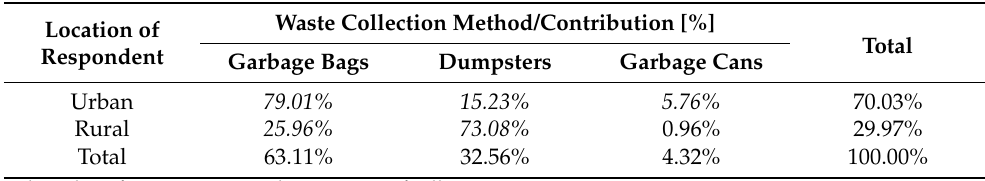
Table 2. Results of multi-partition table of method of waste collection taking into account the location of respondents.